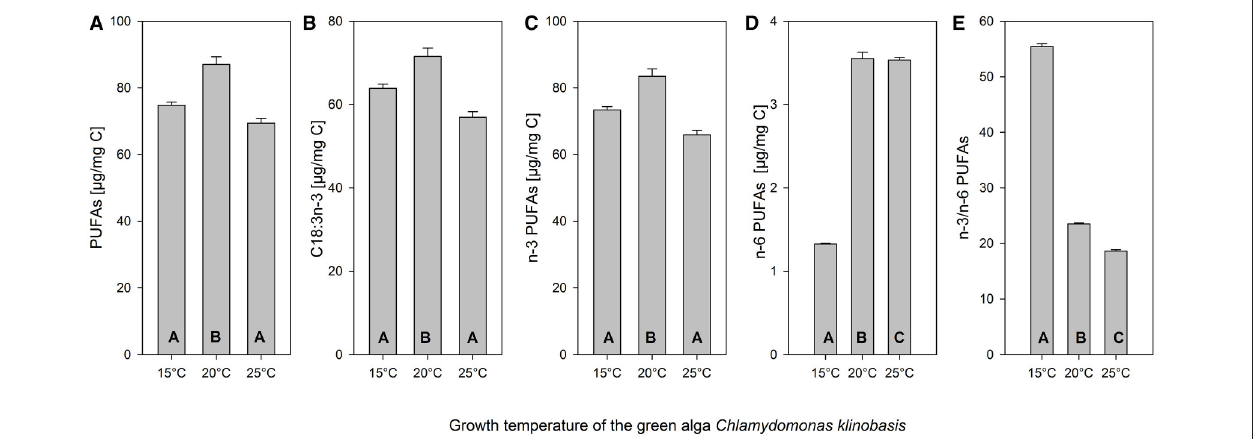
FIGURE 2 | Mean ( + SE, n = 3) fatty acid content of the green alga Chlamydomonas klinobasis grown in continuous cultures at 15, 20, or 25 ◦ C. Depicted are the content (A) of polyunsaturated fatty acids (two and more double bonds, PUFA), (B) of C18:3n-3, (C) of n-3 PUFAs, (D) of n-6 PUFAs, and (E) the ratio of n-3 PUFAs to n-6 PUFAs. Different letters indicate significant differences between treatments (Tukey’s HSD after one-way ANOVA). Note different scale.